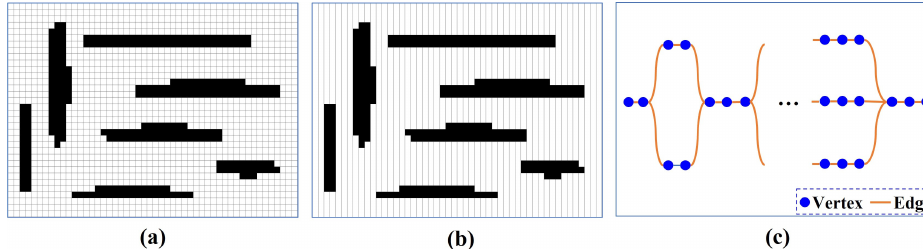
Figure 5. Graph representation. ( a ) The input map. ( b ) Coverage cells. ( c ) The connected